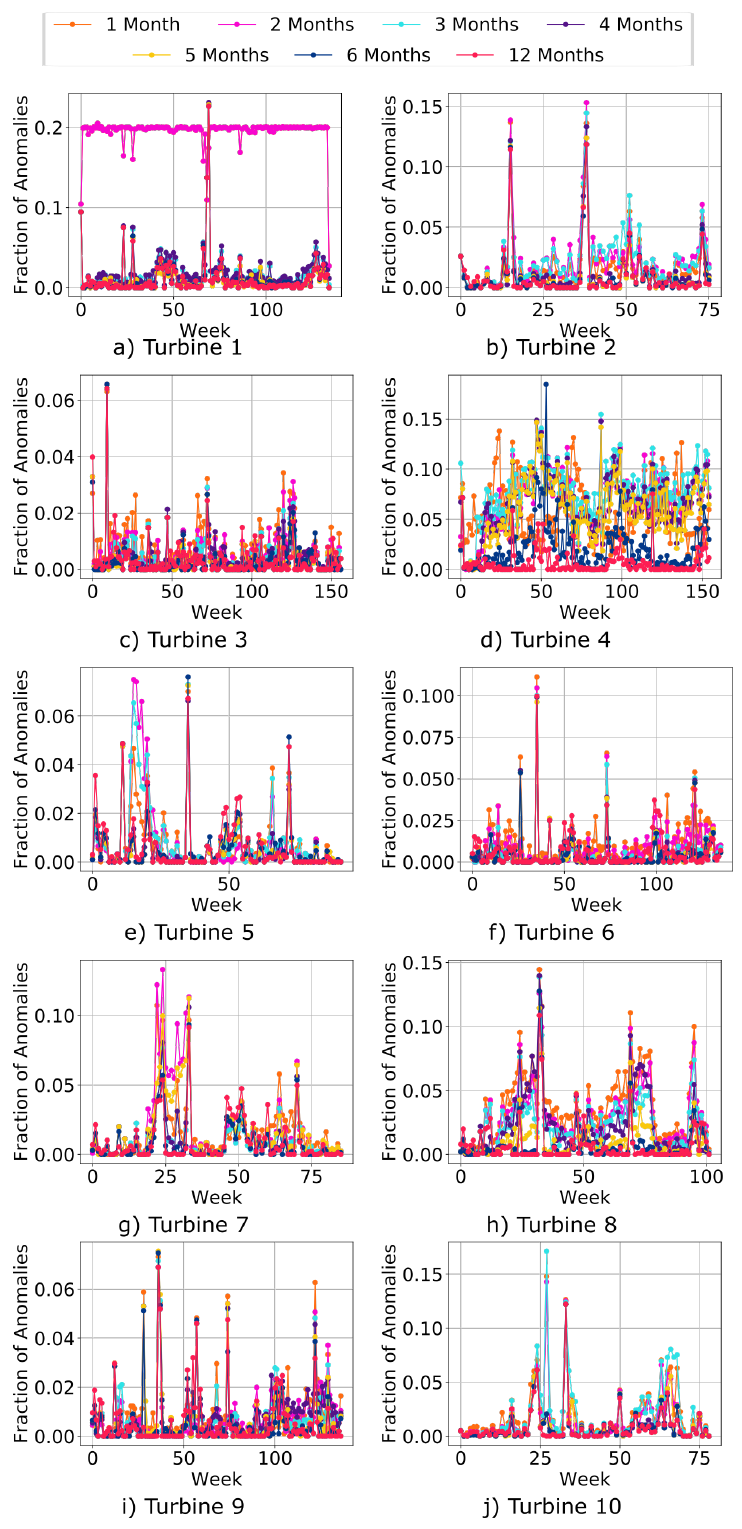
Figure 7. Weekly Anomaly proportions for Case Study 1 without Feedback